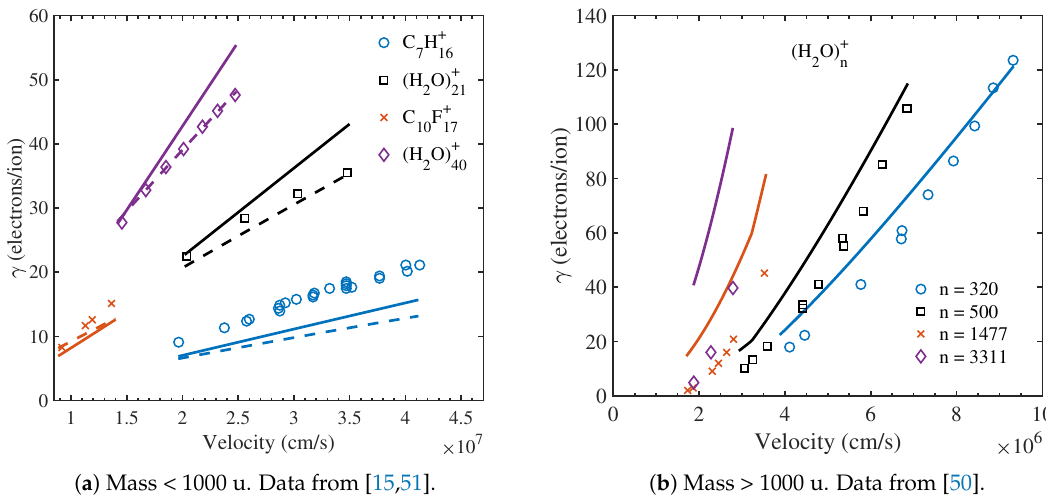
Figure 7. IIEE data as a function of velocity for molecular ions and ion clusters at 18–260 keV on copper. Solid lines are TRIM model predictions and dashed lines are predictions from the Schou model with line colors matching the corresponding